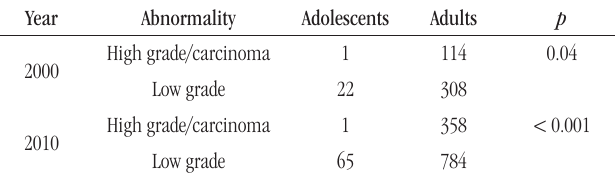
taBLE 2 – Classification of epithelial abnormalities detected in cervical cytology tests from adolescent and adult women in 2000 and